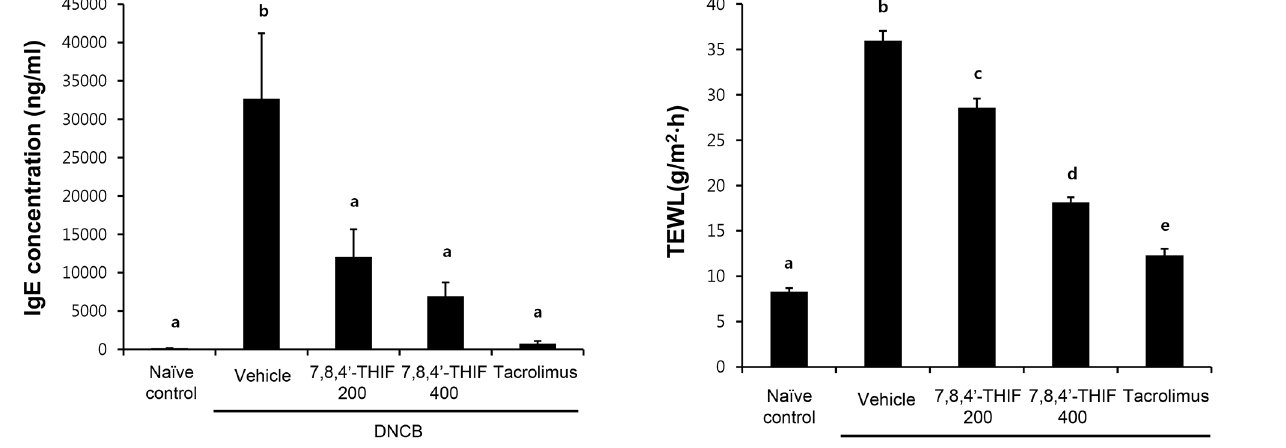
Figure 6. Effect of 7,8,4 9 -THIF on DNCB-induced increase in TEWL in NC/Nga mice. The level of TEWL in mouse dorsal skin was measured using a skin evaporative water recorder on the last day of the experiment (day 21). Data are the means 6 SEM (n=9). Means with letters (a–e) within a graph are significantly different from each other at p ,